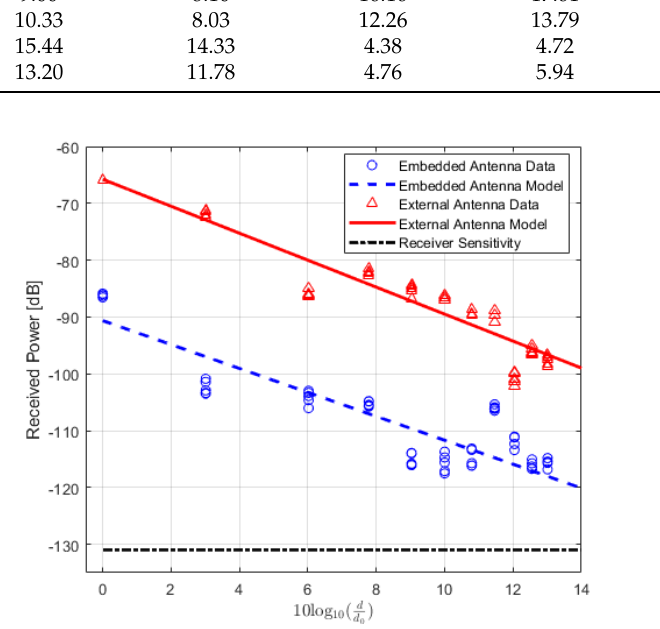
Figure 5. IQRF received power model for Line-of-Sight scenario.